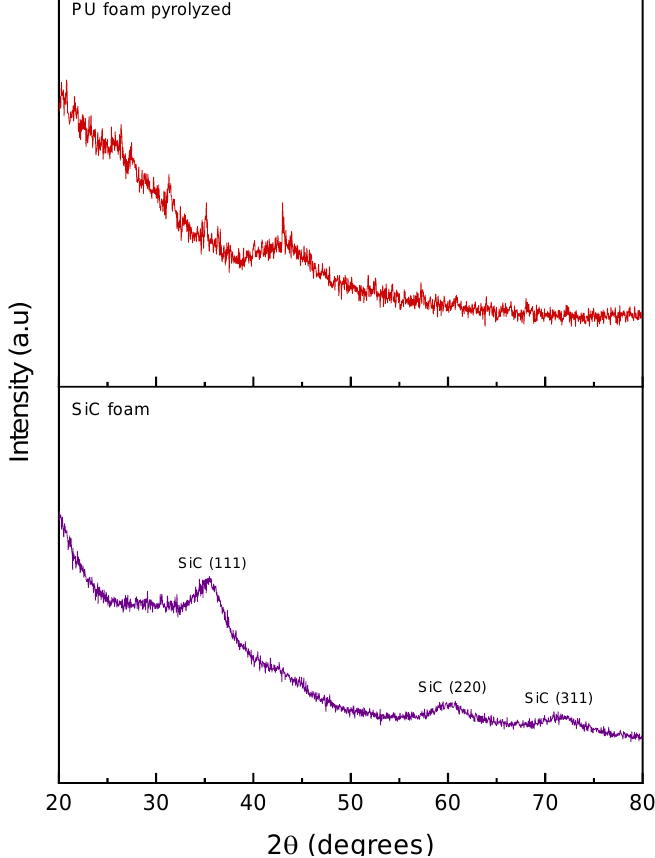
Figure 3. XRD patterns of SiC foam and PU foam template pyrolyzed at 1200 °C.